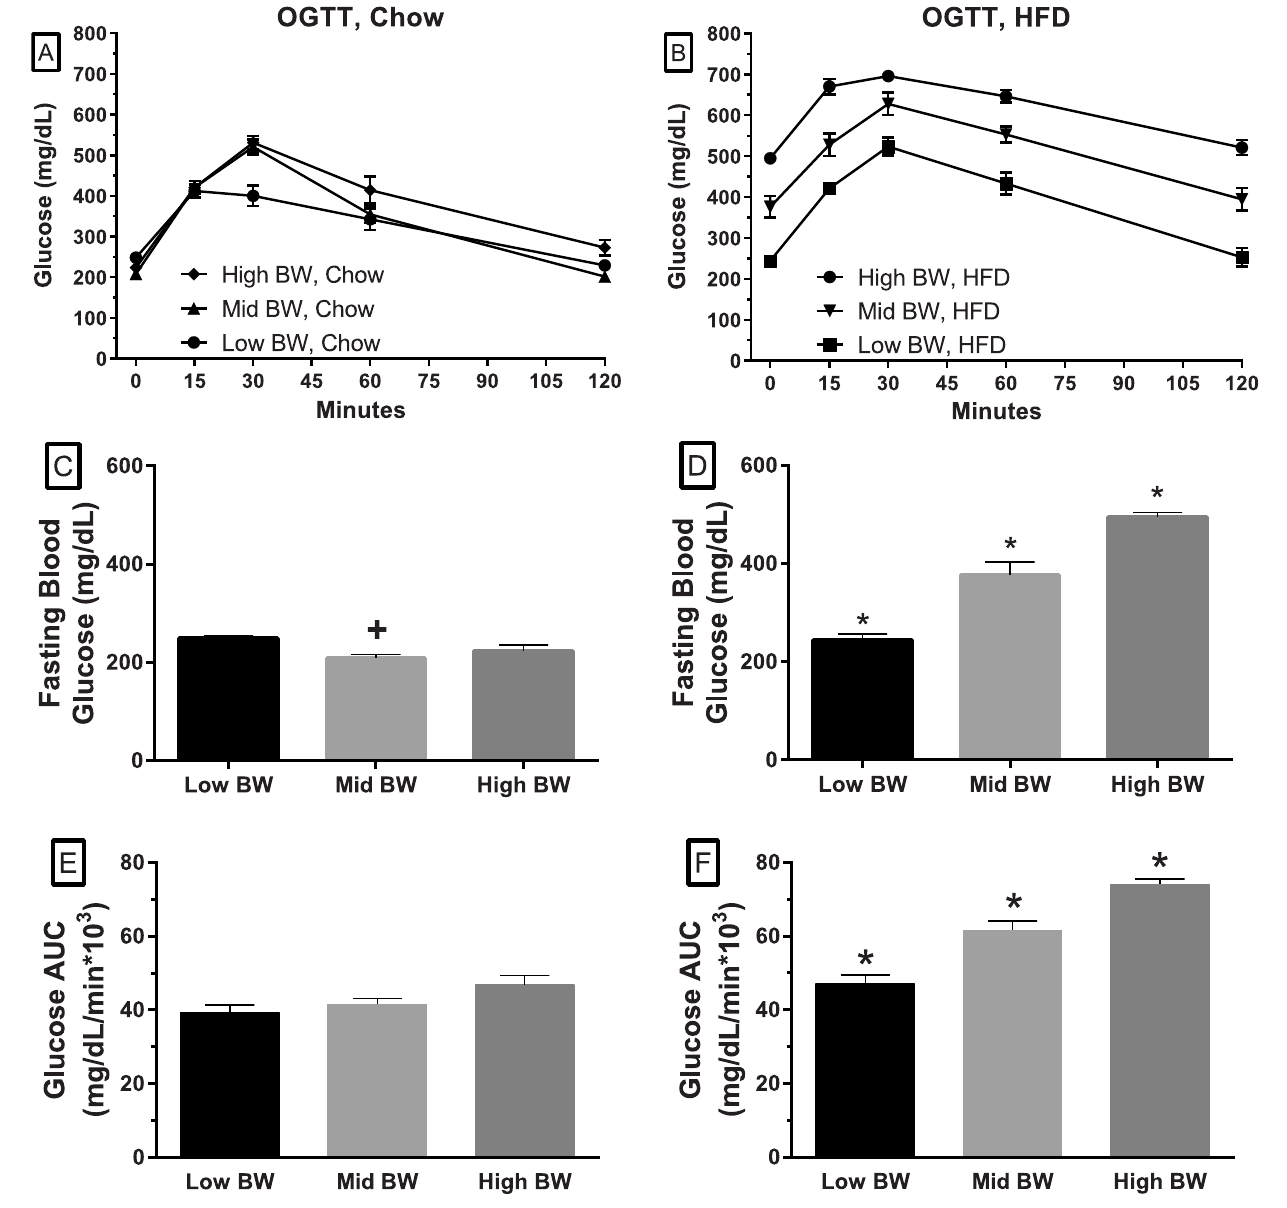
Fig 2. The effects of initial weight and diet on fasting glucose and glucose disposal in an OGTT. The top figures show glucose responses in the OGTT for mice fed the Chow diet (A) and the HFD. Baselineglucoselevels, after a 17 hour fast in the Low, Mid and High BW groupsof mice fed the Chow diet (C) while glucoselevels are significantly higherin the Mid BW and High BW animalson the HFD (D). The figures in the two lower panels illustrate the glucoseAUC from the OGTT for animals in each of the body weight groupswhen fed Chow diet (E) and HFD (F). (one-wayANOVA followedby Sidak’smultiple comparisontests. + denotesa statistical difference comparedto the Low BW and * denotesstatistical from all other group, p < .05).